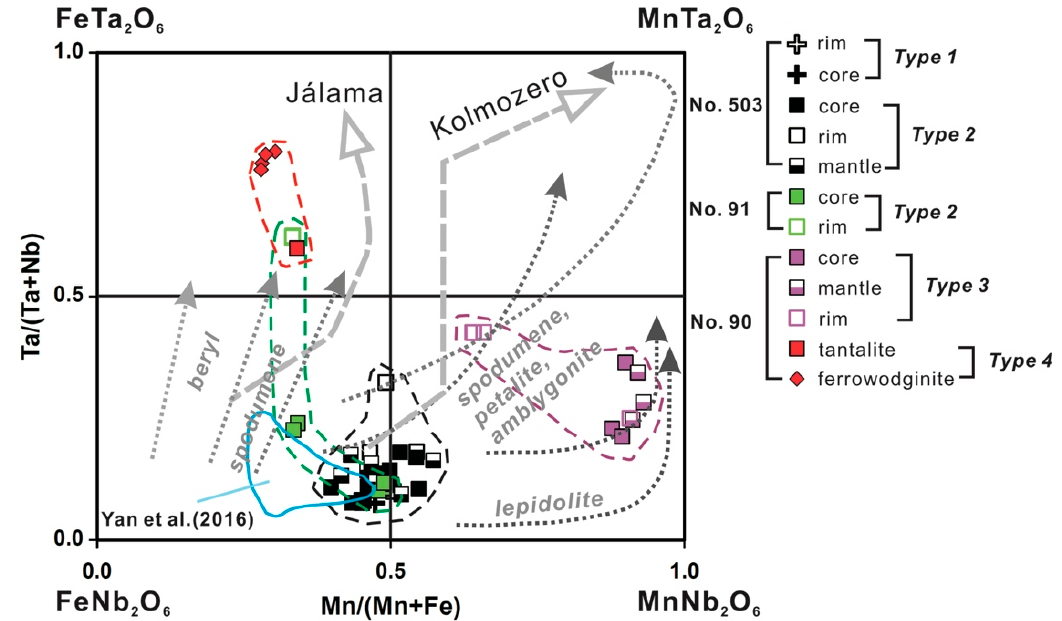
Figure 6. Columbite-Tantalite quadrilateral (after [45]) for CGM and ferrowodginite from No. 90, 91 and 503 pegmatites. Evolutionary trends of CGM compositions from Jálama and Kolmozero are generalized using the relevant data provided in [14] and [8], respectively. Generalized evolutionary trends of CGM compositions occurring in beryl- and complex- (spodumene, petalite, amblygonite and lepidolite) types of rare-element pegmatites are modified after [11,45]. The field circled by a blue line in the diagram represents the compositions of CGM in [21].